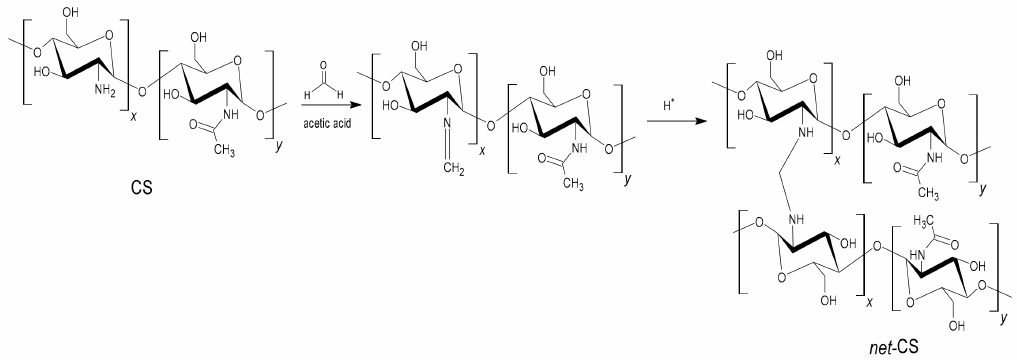
Figure 2. Crosslinking reaction of